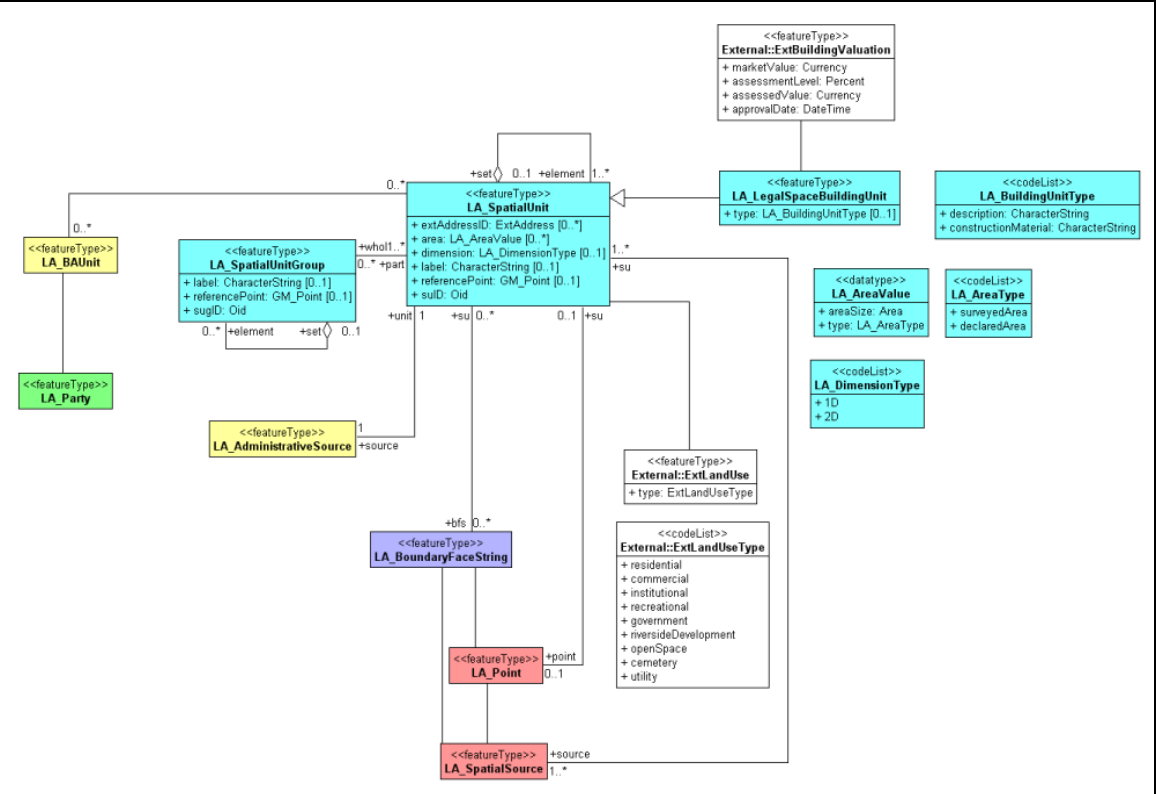
Figure 6 . Localized classes of the Spatial Unit